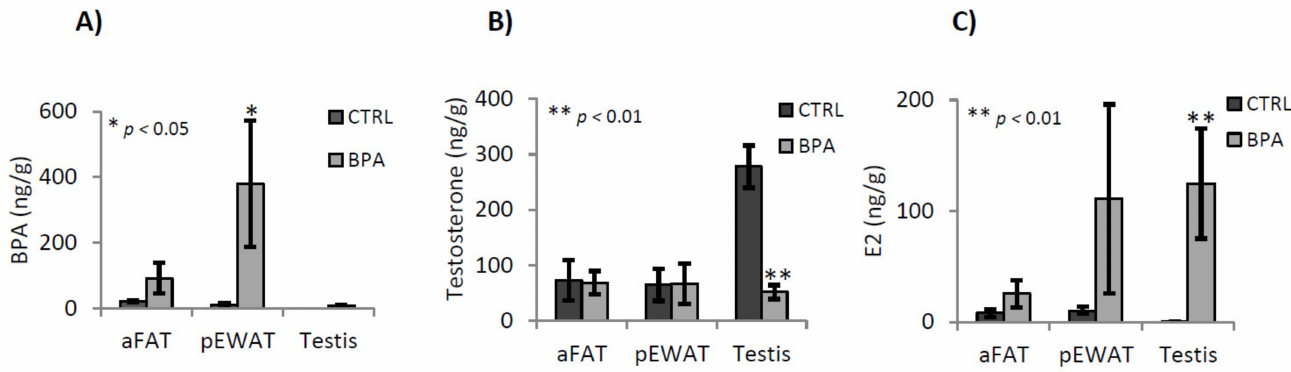
Figure 1. Analysis of BPA ( A ), testosterone (T) ( B ) and 17-beta-estradiol (E2) ( C ) content (as ng/g) in white abdominal (aFAT) and epididymal (pEWAT) adipose tissue and in testis of male mice early-life exposed to vehicle (CTRL, n = 3/4) or BPA (BPA, n = 4) and sacrificed at 78 dpp . All the data were reported as mean value ± S.E.M. (*: p < 0.05; **: p <